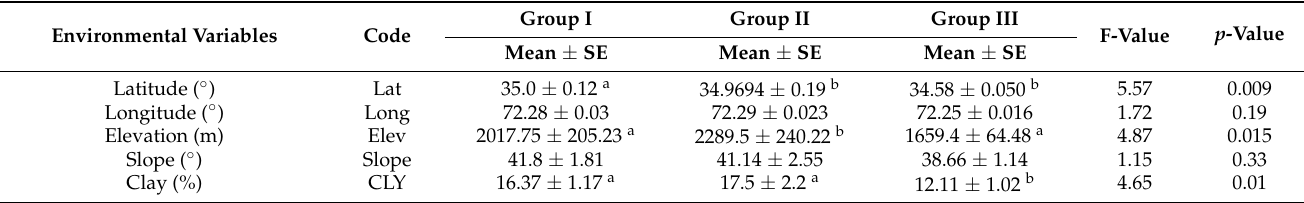
Table 5. Average values (Mean ± stand error) of the environmental variables, i.e., topographic, edaphic and soil in the three community types (vegetation groups) separated by Ward’s agglomerative cluster analysis. The three groups were Group I (Quercus baloot–Pinus roxburghii), Group II (Quercus semecarpifolia–Quercus robur), and Group III (Quercus lanata–Olea